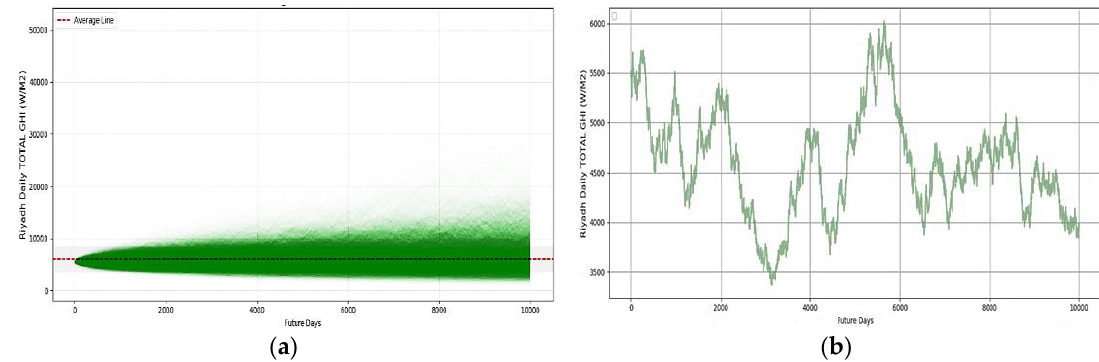
Figure 7. ( a ) Daily total solar global horizontal irradiance (GHI) distributions for the central region, as predicted by Monte Carlo Simulation (MCS) and Brownian Motion (BM), and ( b ) a one-day scenario for the solar GHI distribution prediction performance. Energies 2020 , 13 , x FOR PEER REVIEW 12 of 17